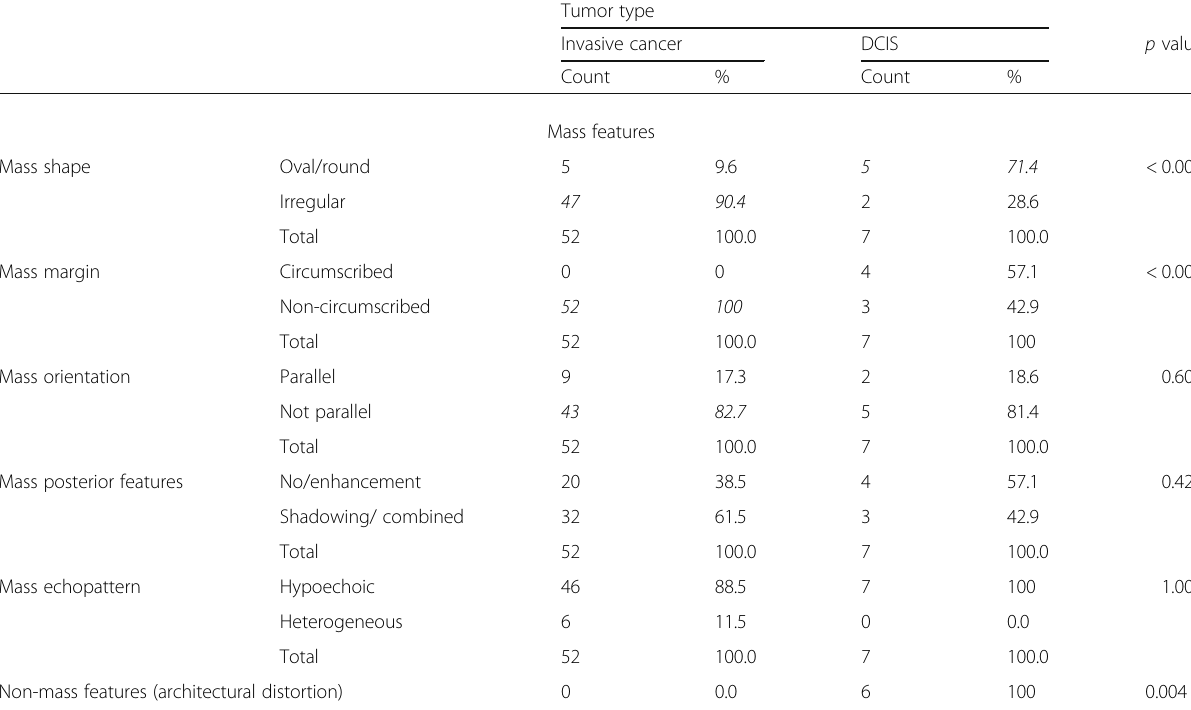
Table 2 Association between tumor type and ultrasound findings of the breast cancers